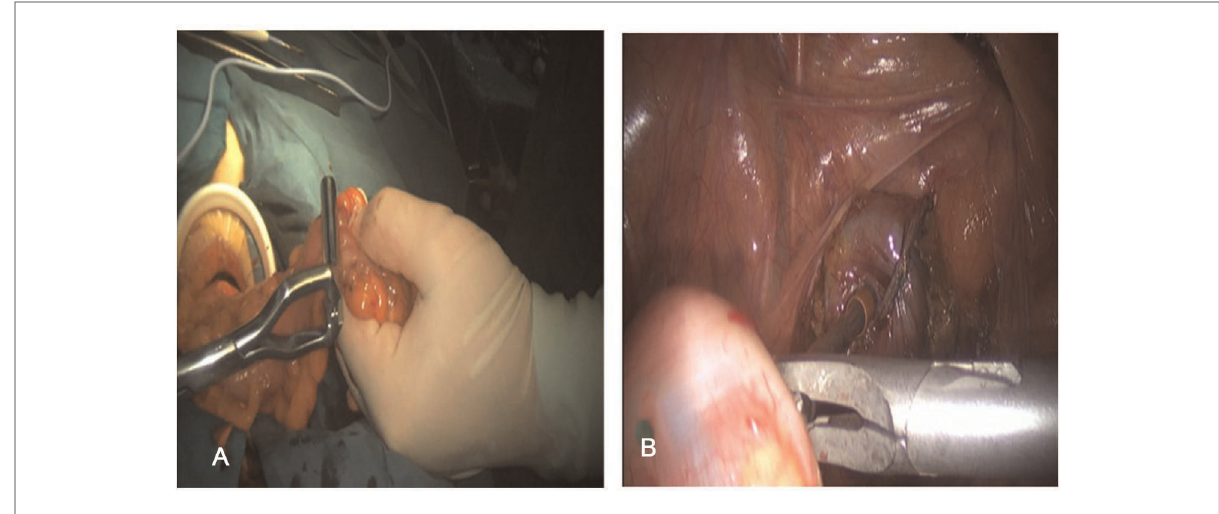
FIGURE 3 3D or 2D laparoscopic assisted Dixon method to preserve the anus, ( A ) The assisted abdominal wall incision to remove the specimen; ( B ) The colorectal anastomosis is completed through the